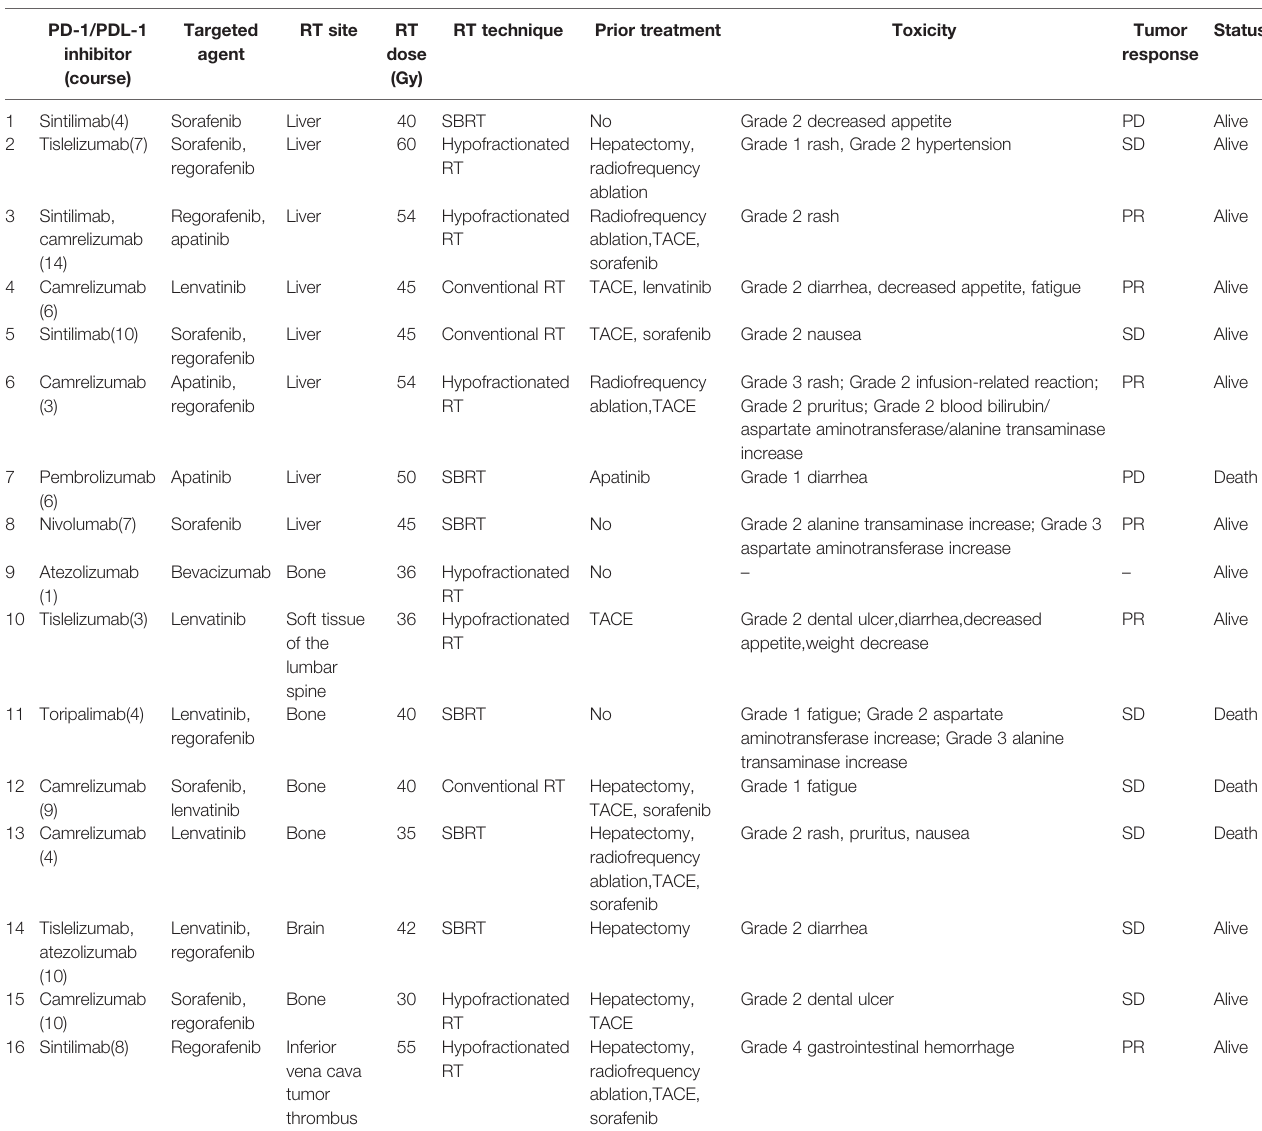
TABLE 3 | Treatment details, toxicities, and outcome of